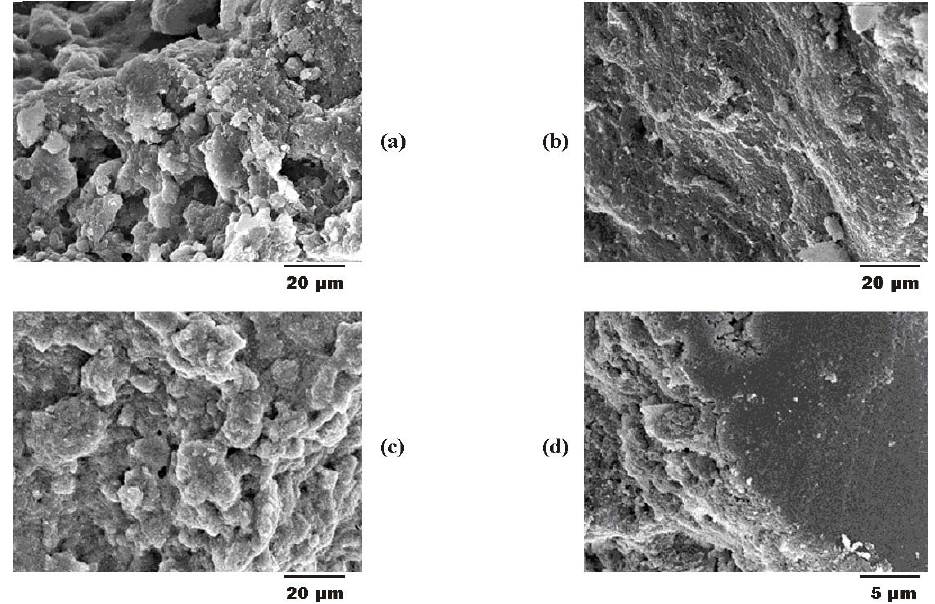
Figura 3. Foto micrografias obtidas em microscópio eletrônico de varredura (MEV) de amostras do solo sob mata nativa (camada 0–0,2 m), após teste de compressão uniaxial. (a) σσσσσ